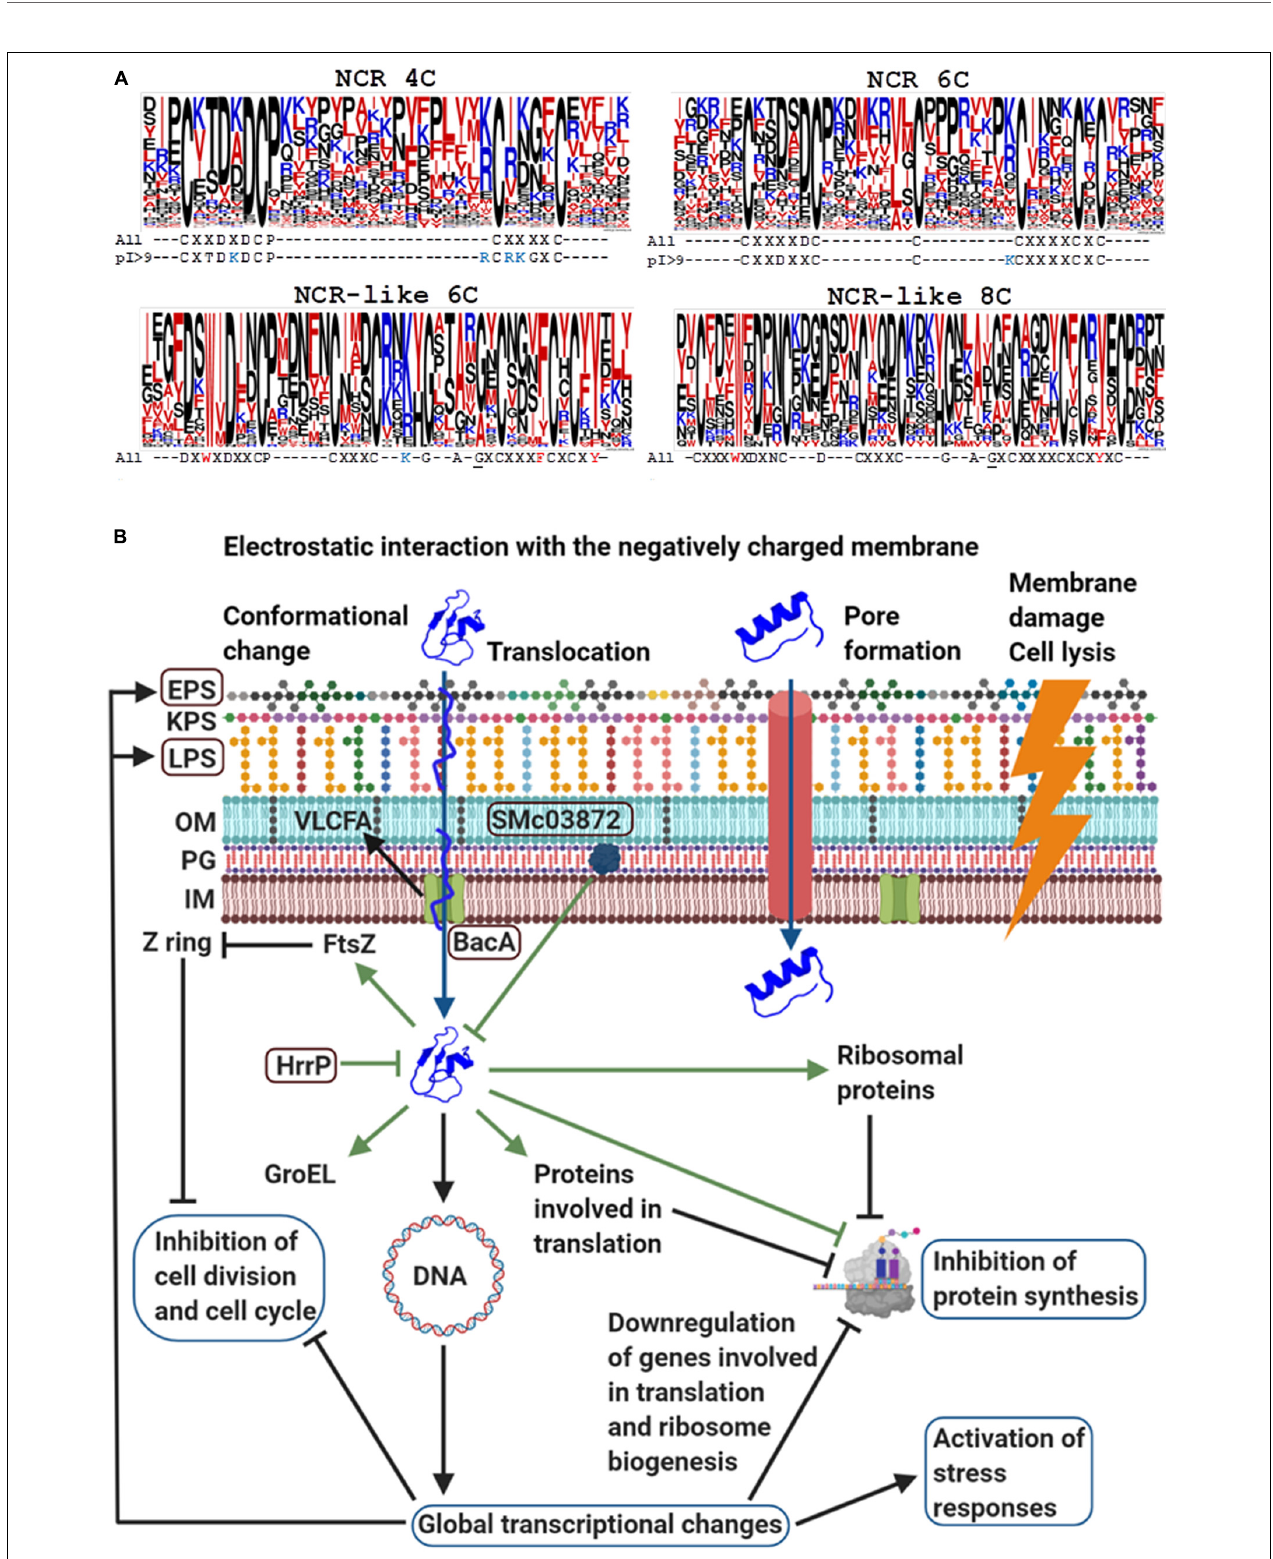
FIGURE 1 | The structure of NCRs, NCR-like peptides (A) and the mode of actions of cationic NCRs (B) . (A) Frequency of amino acids and conserved patterns of cysteines in the mature M. truncatula NCRs and NCR-like peptides from Dalbergioid legumes. The height of letters in the stacks indicates the relative frequency of